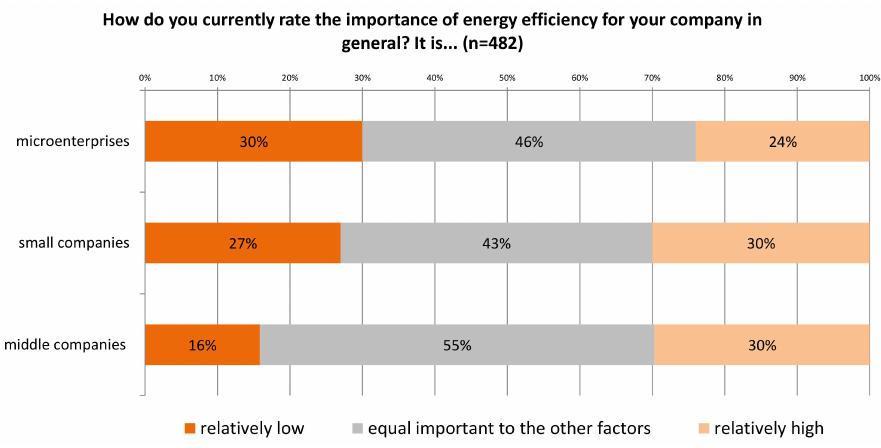
Figure 4. Current importance of energy e ffi ciency by enterprise size.